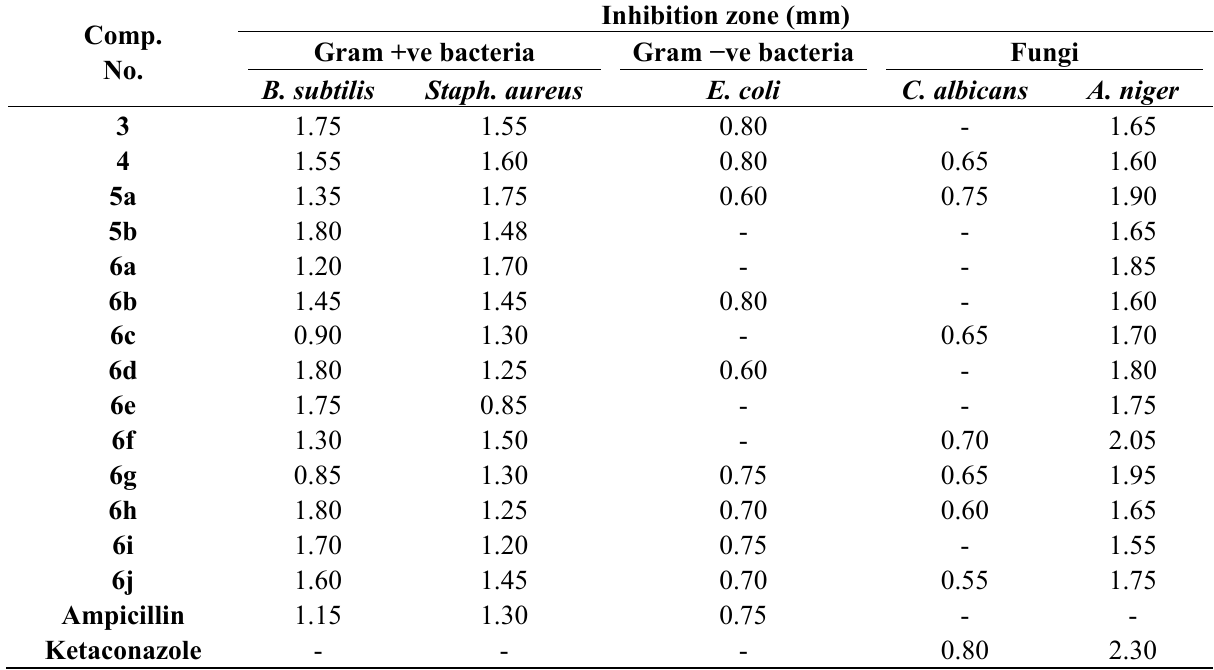
Table 2. Antimicrobial activities of new synthesized compounds 4 , 5a , b and 6a – j .